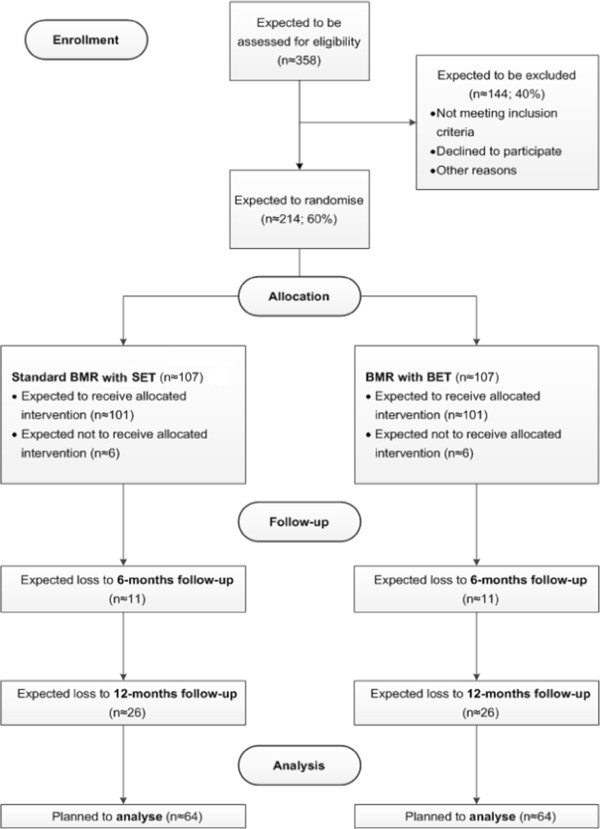
Study Flow Diagram.